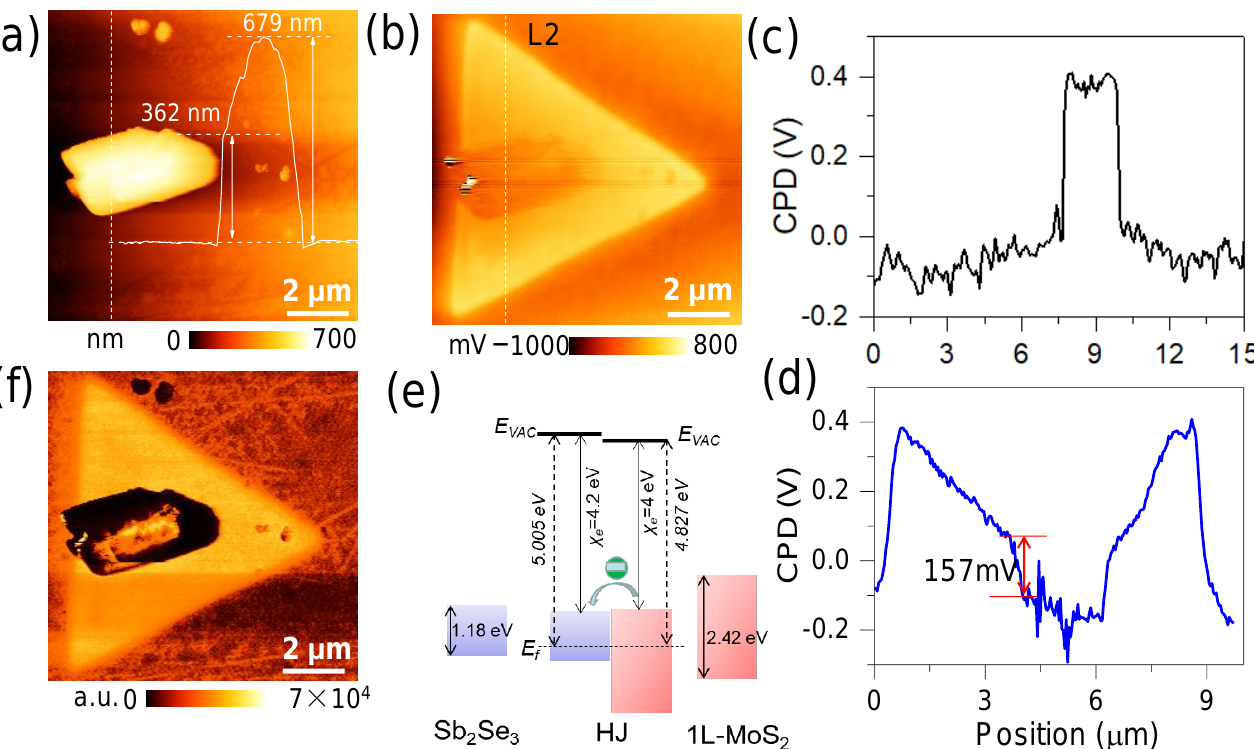
Figure 4. ( a ) AFM topography and ( b ) CPD images of a Sb 2 Se 3 /1L-MoS 2 HJ. Height profile across the Sb 2 Se 3 flake is plotted as an inset in ( a ). CPD profile along dashed line L1 ( c ) in Figure S5b and L2 ( d ) in ( b ). ( e ) Band alignment diagram of the Sb 2 Se 3 /MoS 2 HJ. EVC is the vacuum energy level. ( f ) capacitance image of the HJ in ( b ).